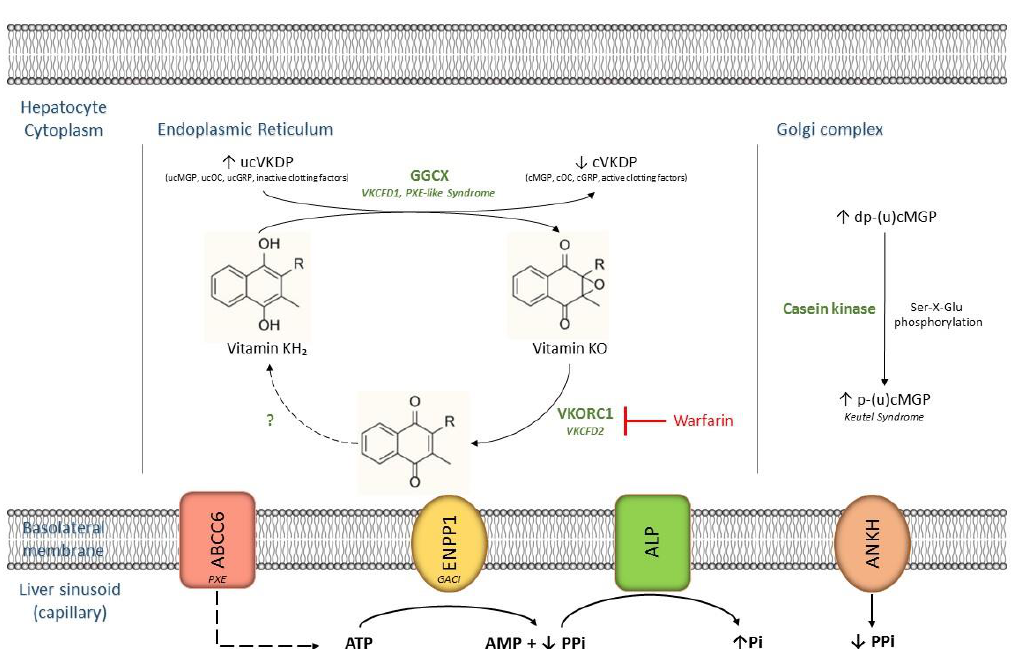
Figure 1. Schematic representation of vitamin K metabolism and related compounds in hepatocytes. Arrows indicate differential expression of molecular targets as observed in ectopic mineralization pathophysiology. Note that dp-ucMGP (an extrahepatic VKDP) is mainly synthesized in VSMCs and chondrocytes, and is thereafter transported to the liver. Post-translational modification then takes place in hepatocytes as shown above. ABCC6: ATP-binding cassette transporter subfamily C member 6. ALP: alkaline phosphatase. AMP: adenosine monophosphate. ANKH: progressive ankylosis